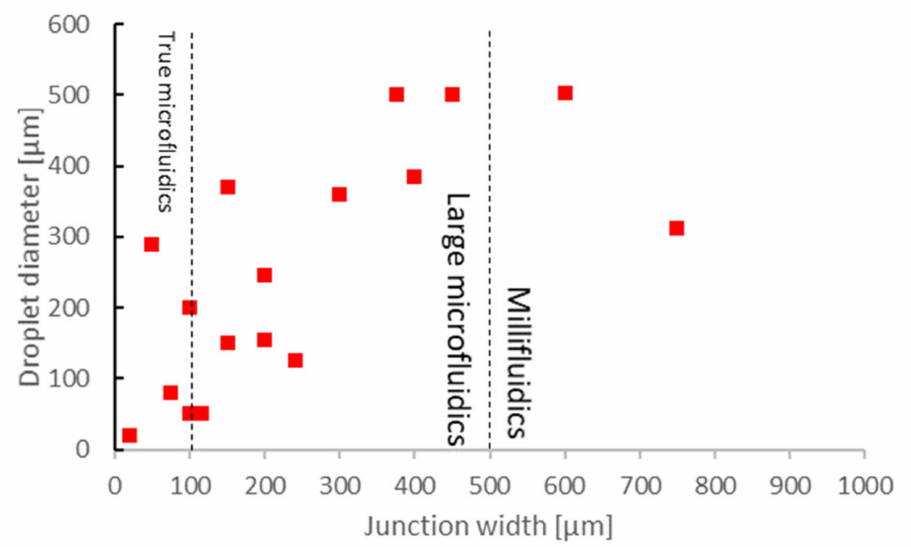
Figure 4. In droplet microfluidics, 3DP microfluidic chips have been mostly used in a 100–500 µ m junction width regime (large microfluidics). The droplet diameter changes close to linearly with the junction width, typically also in the 100–500 µ m range, although some variations are possible due to different reagents and flow rates used. By using a wider outlet and a lower flow rate, the droplet diameters can be significantly larger than the junction width. Conversely, a high flow rate can result in smaller droplets than the junction